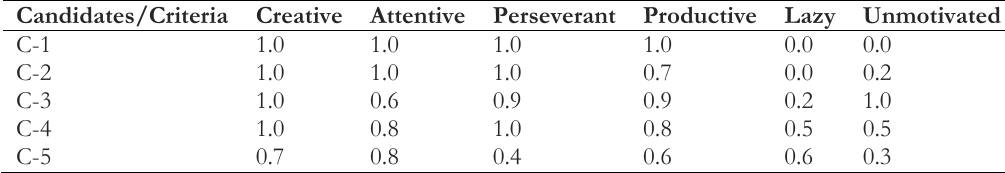
Table 16. The new evaluation matrix for the first sensitive analysis.